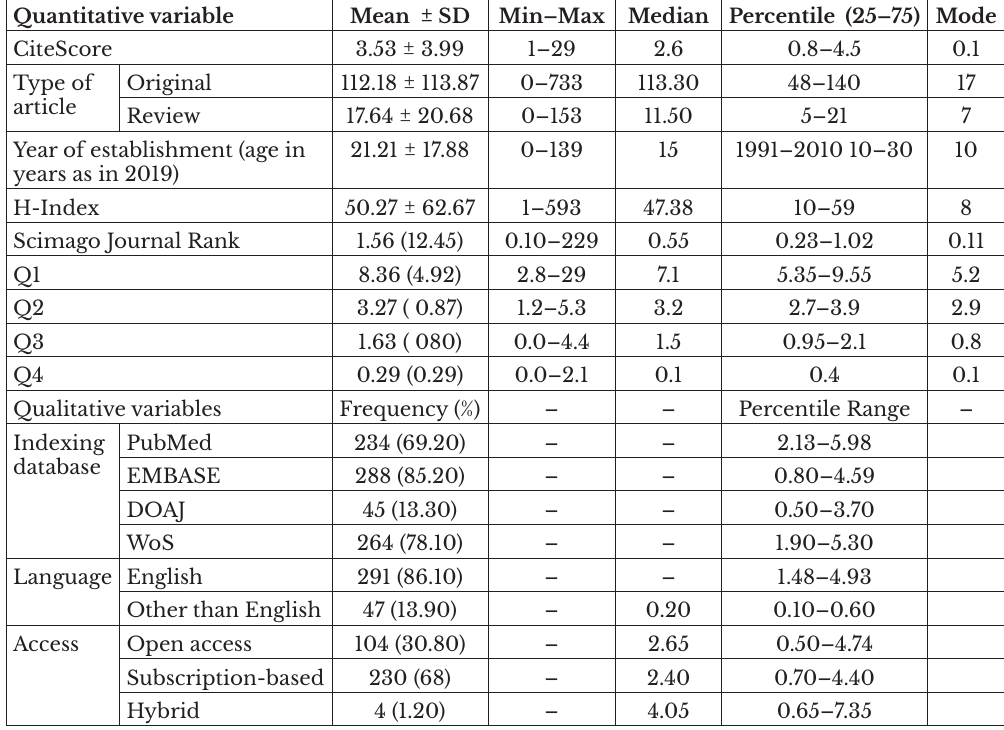
Table 1. Descriptive statistics of variables related to journals in cardiology and cardiovascular diseases indexed in Scopus in 2019 (n = 338) Quantitative